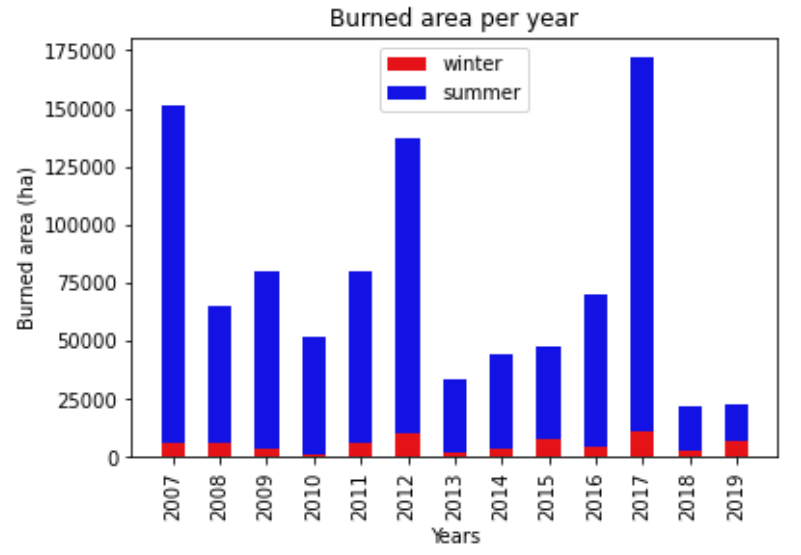
Figure 5. Seasonal wildfire burned area in Italy per year based on the historical dataset used in this study (2007–2019). The wildfires occurred in winter season are presented in red colour while the ones occurred in summer season are presented in blue